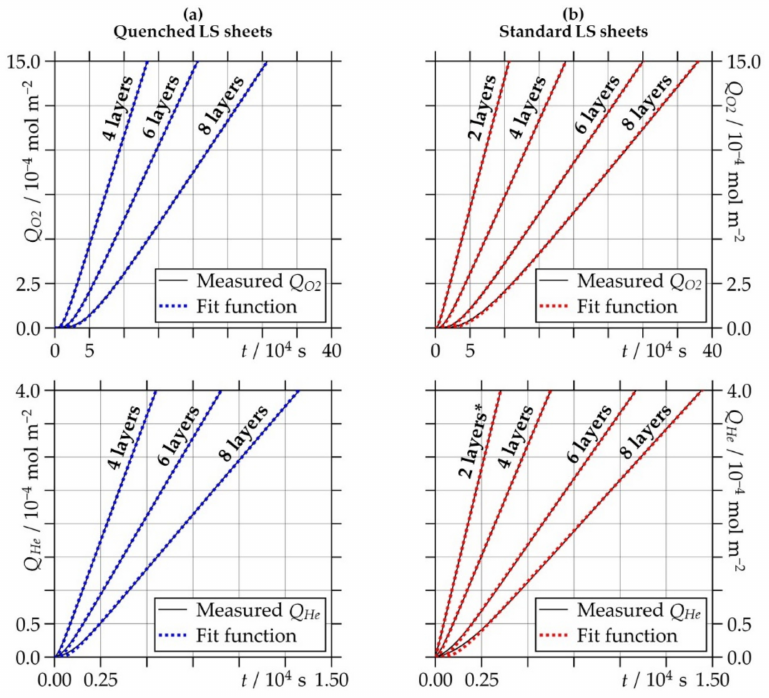
Figure 10. Measured permeated quantities of oxygen ( Q O2 ) and helium ( Q He ) versus time ( t ) and cor- responding data fits to Equation (1) or, if marked with an asterisk, to Equation (2) for ( a ) quenched and ( b ) standard laser-sintered (LS) polyamide 12 sheets generated with two, four, six, and eight layers. Table 4. Oxygen and helium diffusion coefficients ( D O2 / D He ), solubility coefficients ( S O2 / S He ), and permeation coefficients ( P O2 / P He ) of quenched and standard laser-sintered (LS) polyamide 12 sheets generated with two, four, six, and eight layers. Number of Layers